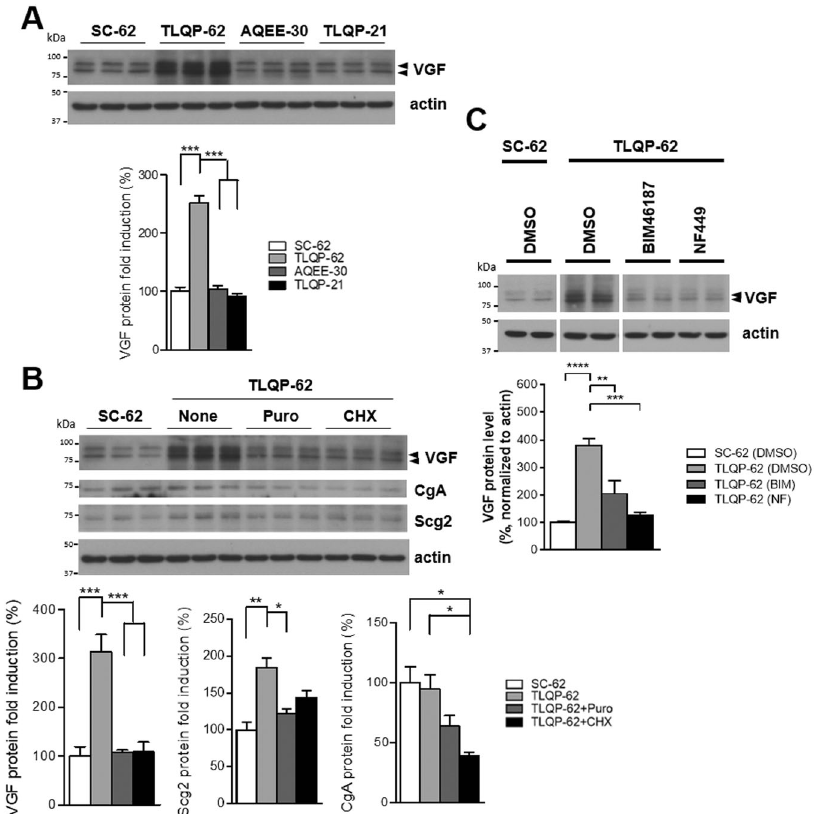
Fig. 3 Acute increases in VGF and Scg2 protein levels mediated by VGF-derived TLQP-62 depend on mTOR and GPCR signaling. A N38 cells were treated with the indicated peptides (SC-62, TLQP-62, AQEE-30, or TLQP-21, 10 μ M) for 10 min. Cells were harvested and analyzed for VGF protein expression using immunoblotting. N = 3 per group. Densitometry results are presented as the mean percentage ± s.e.m. and were analyzed using one-way ANOVA with Tukey ’ s post hoc test. ***, p < 0.001. B N38 cells treated with TLQP-62 (10 μ M) for 10 min showed robust increases in levels of the VGF and Scg2 proteins, while CgA protein levels remained unchanged. Inhibitors of protein translation, puromycin (Puro, 130 μ g/ml) and cycloheximide (CHX, 40 μ M), each inhibited the TLQP-62-induced increases in VGF and Scg2 protein levels